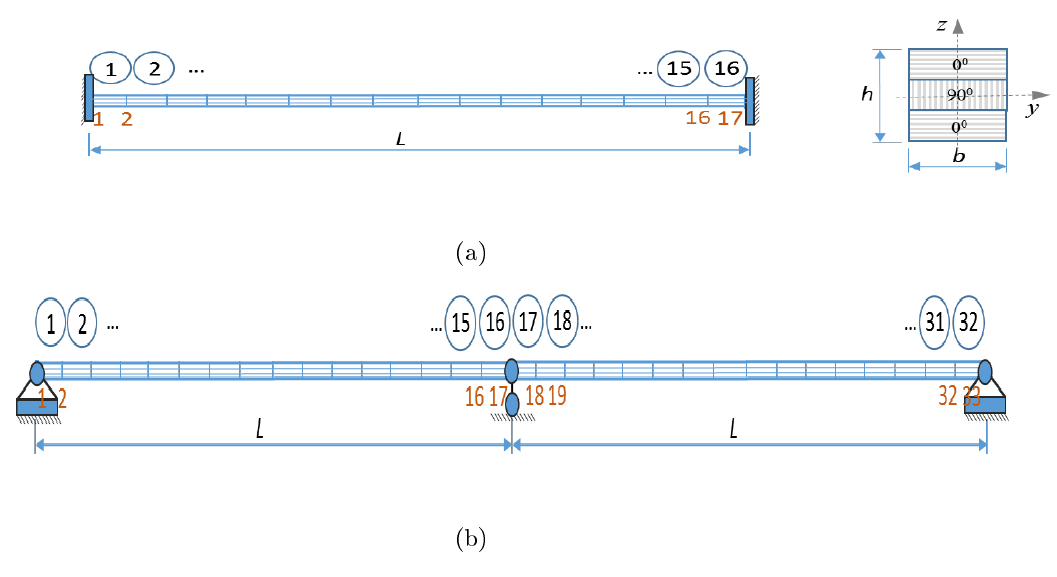
Fig. 1.(a) Clamped(cid:21)clamped cross-ply ( 0 o / 90 o / 0 o ) beam, (b) Two-span continuous cross-ply ( 0 o / 90 o / 0 o ) beam. Table 1. Three hypothetical damage scenarios in each composite beam. Scenarios Description Damaged